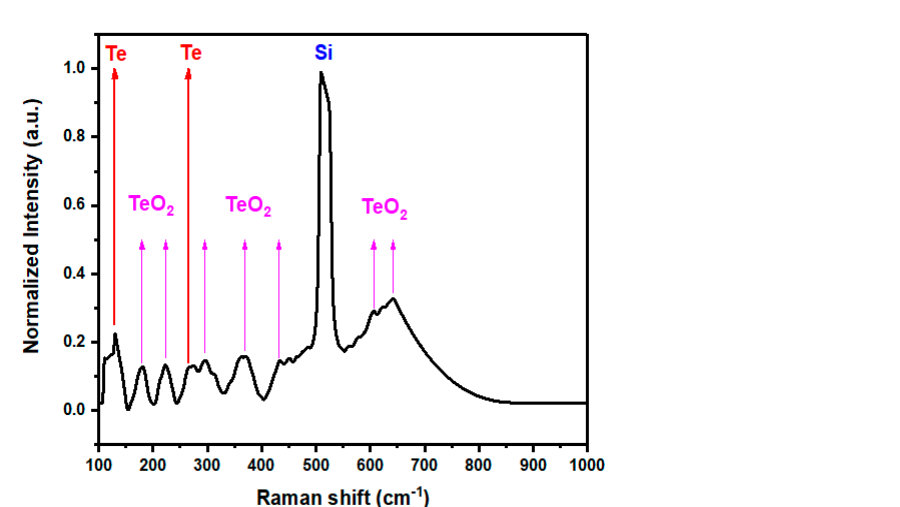
Figure 3. Raman spectra of the AV-TeNPs deposited on top of a silicon wafer. The peaks of Te and TeO 2 are clearly identified.